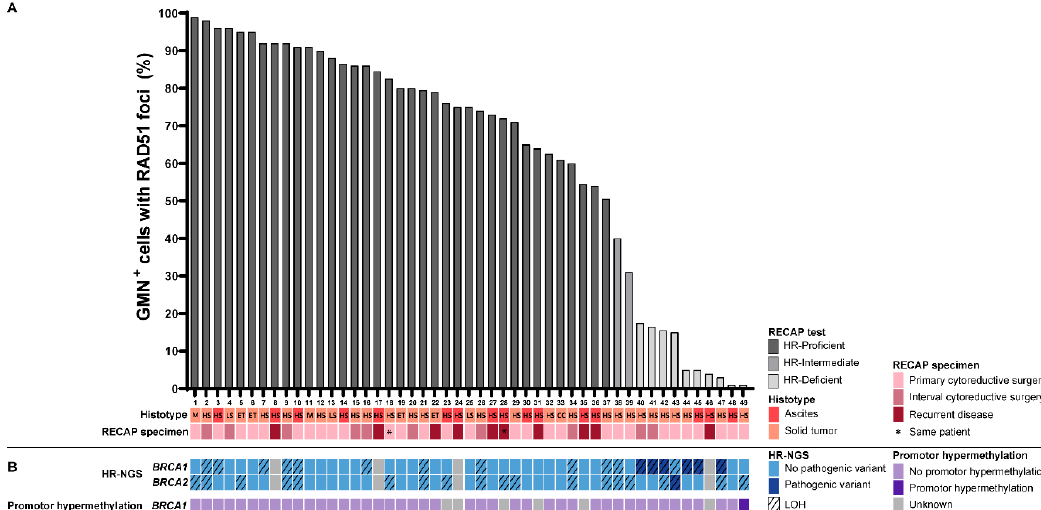
Figure 2. RECAP scores of 49 EOC tumor specimens. ( A ) RECAP scores were calculated as the average percentage of GMN + cells with ≥ 5 RAD51 foci scored by two independent observers, and specimens were classified as HRP (51–100%), HRI (21–50%) or HRD (0–20%). ( B ) NGS analysis identified seven HRD tumors harboring a pathogenic variant in BRCA1 or BRCA2 with concomitant LOH. No pathogenic variants in BRCA1 or BRCA2 were identified in HRI and HRP tumors. BRCA1 promoter hypermethylation was observed in case 49. Pathogenic variants in other HR genes were tested in the HRD and HRI tumors, but none were identified. Abbreviations: HR = Homologous Recombination;